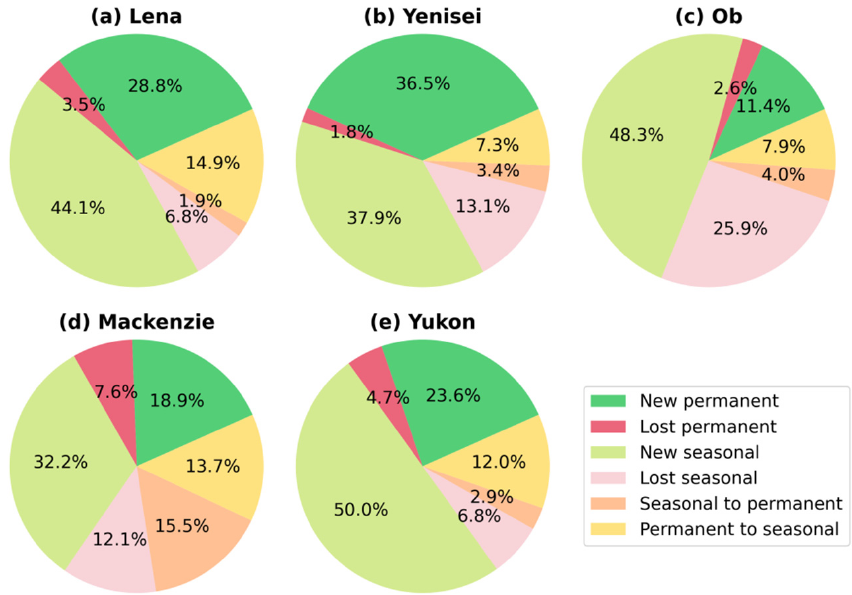
Figure 6. Area proportions of the six changed surface water categories in the five basins.